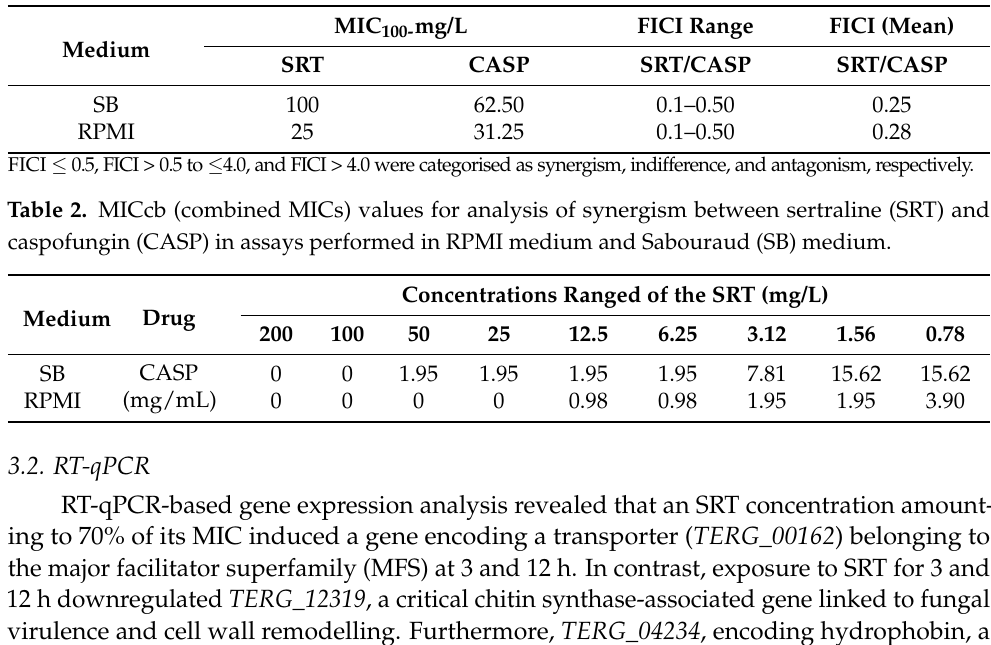
Table 1. MICs of sertraline (SRT) and caspofungin (CASP) against planktonic forms of T. rubrum . FICI and the mean of FICI of interactions between SRT and CASP.